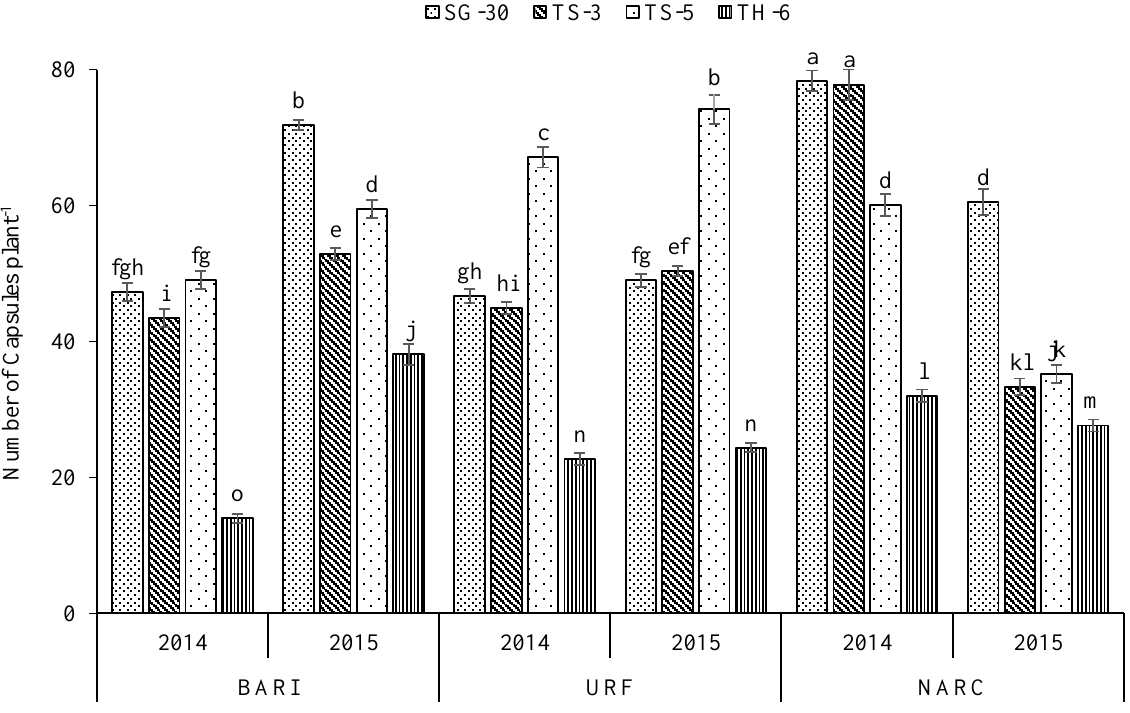
Figure 5. Capsules plant − 1 of four sesame cultivars at three locations during 2014 and 2015 (pooled over micronutrients). The bars indicates standard error ( ± SE) of mean (n = 3). All means are significantly different at p ≤ 0.05.